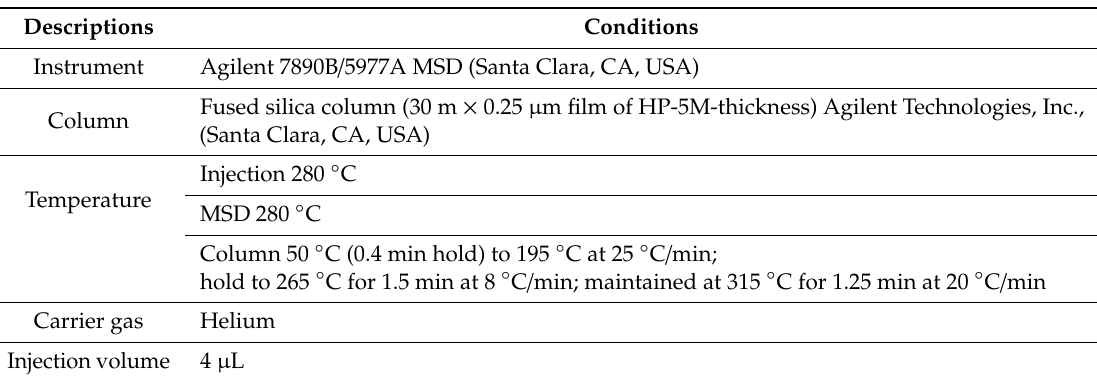
Table 2. The GC operating